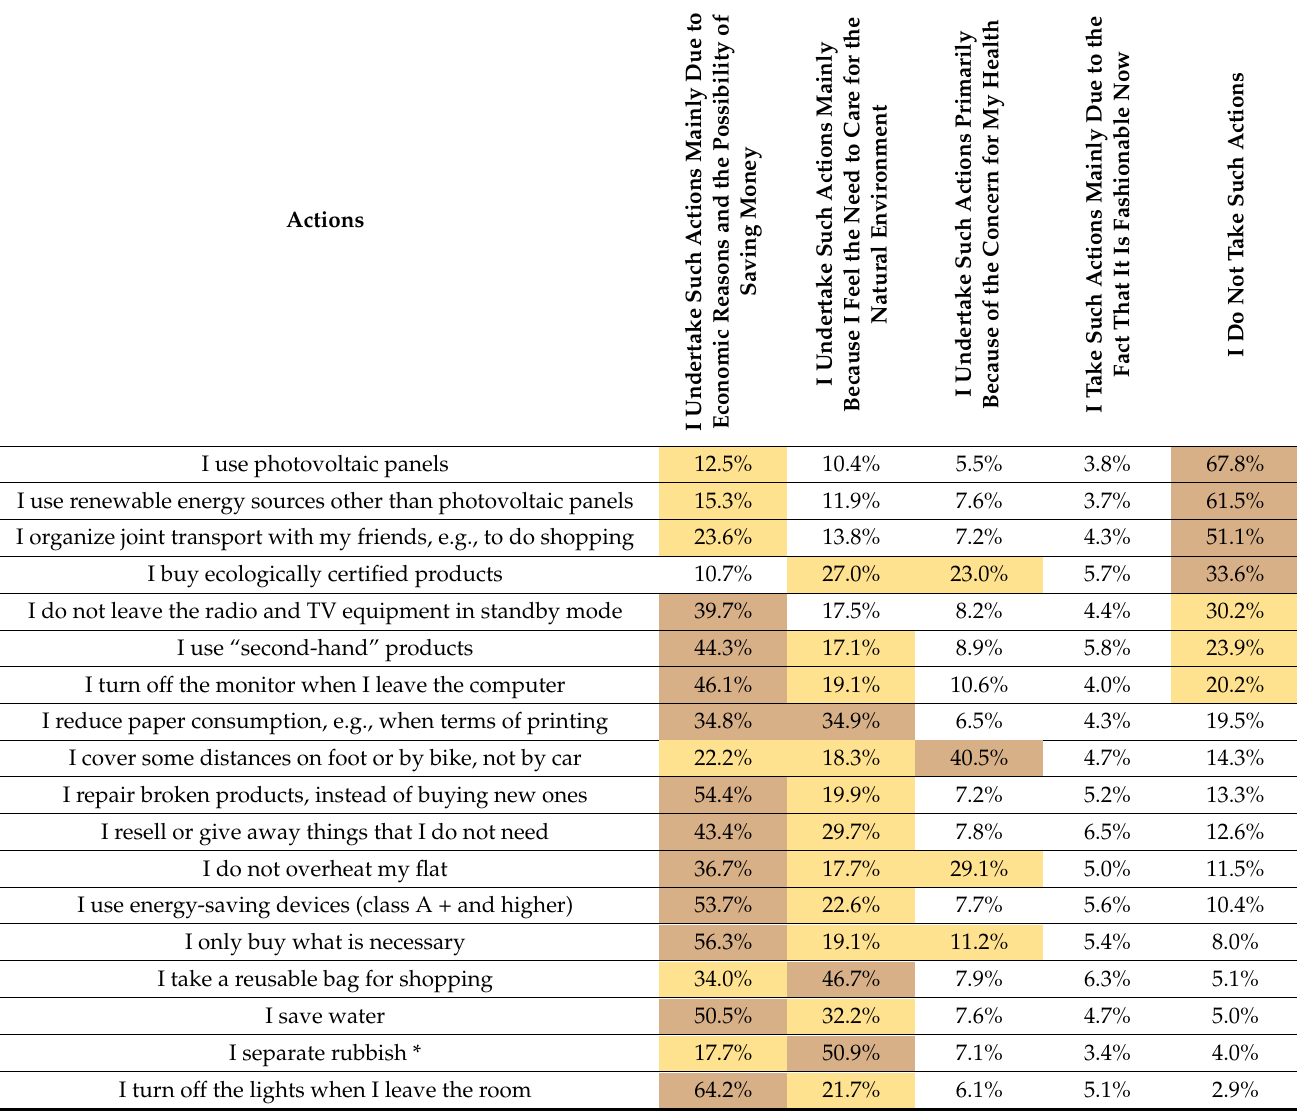
Table 2. Motives encouraging consumers to use photovoltaic panels and to implement other be- haviours that fit into the model of sustainable